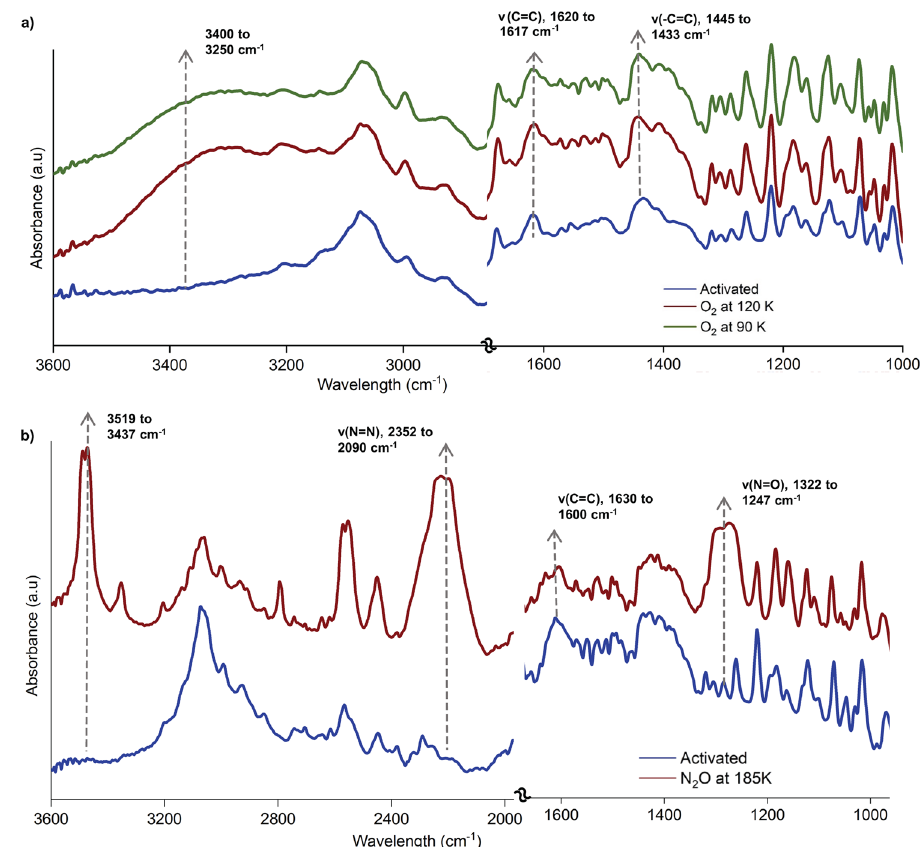
Fig. 5 In-situ FT-IR spectra. a In-situ FT-IR data were measured upon O 2 ( a ) and N 2 O adsorption ( b